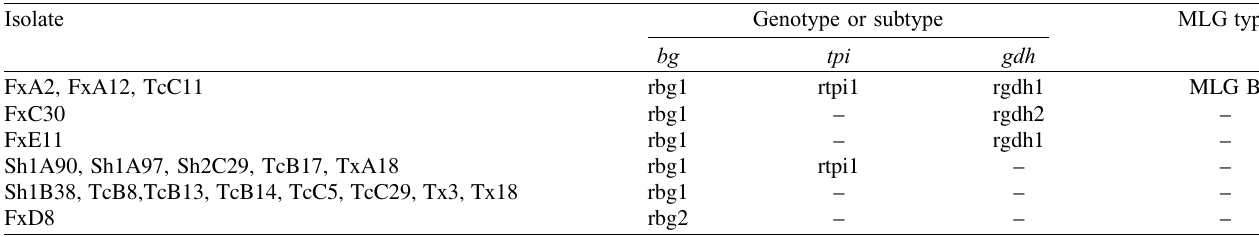
Table 3. Multilocus characterization of Giardia duodenalis isolates based on the bg , tpi and gdh genes.